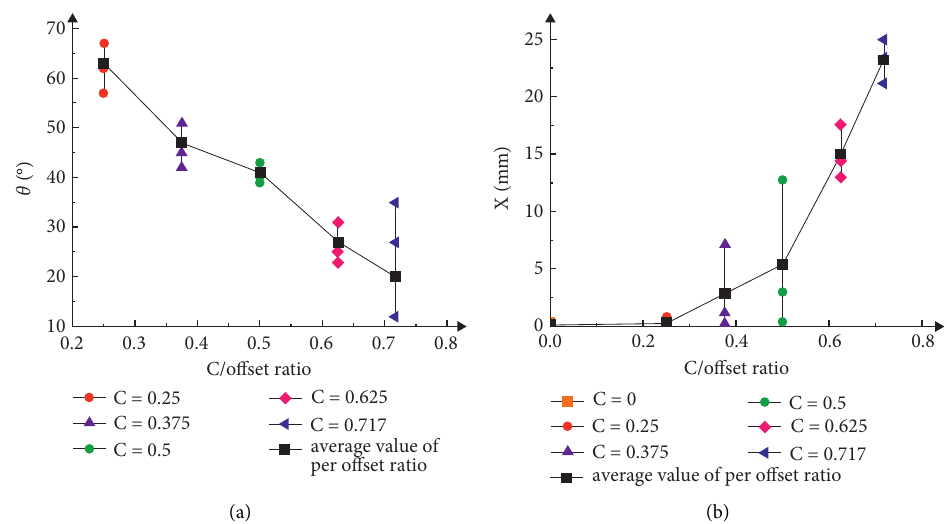
Figure 9: The trends of θ and (X) in the specimens with the increase of offset ratio C . (a) Initial crack angles θ vs. offset ratio C ; (b) the distance between the terminal crack point and the center line (X) vs. offset ratio C